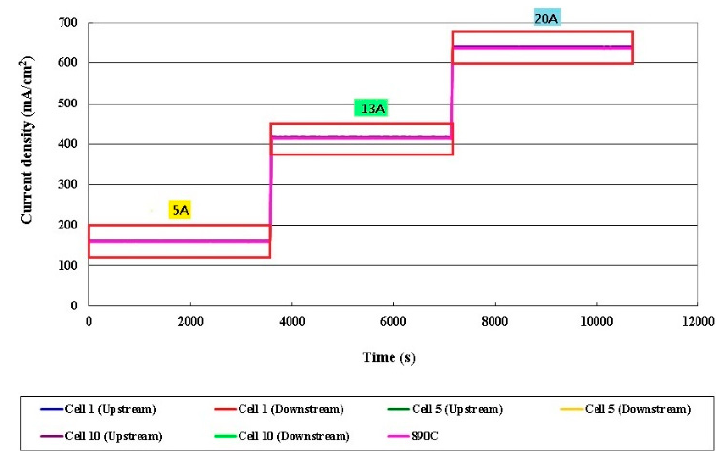
Figure 13. Comparison of local current densities in different cells.